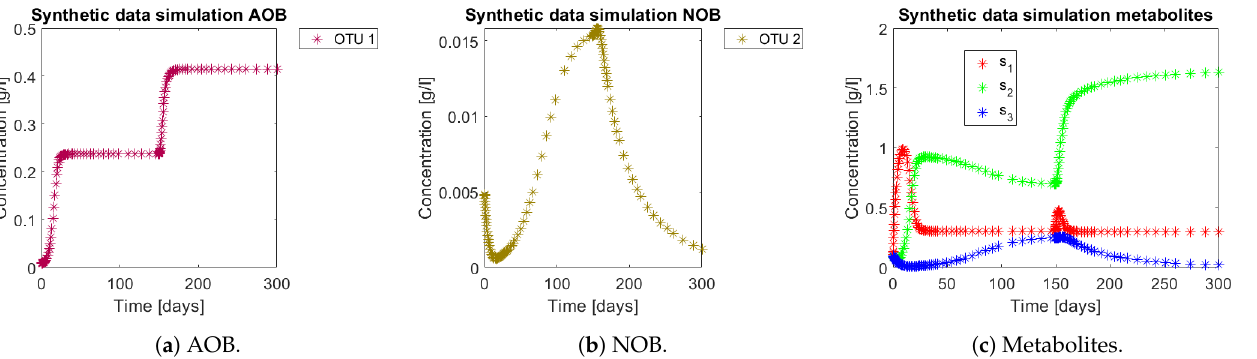
Figure 5. Synthetic data generated by model (3), with parameters from case study 1. Note the effects of the increased input s in generated in day